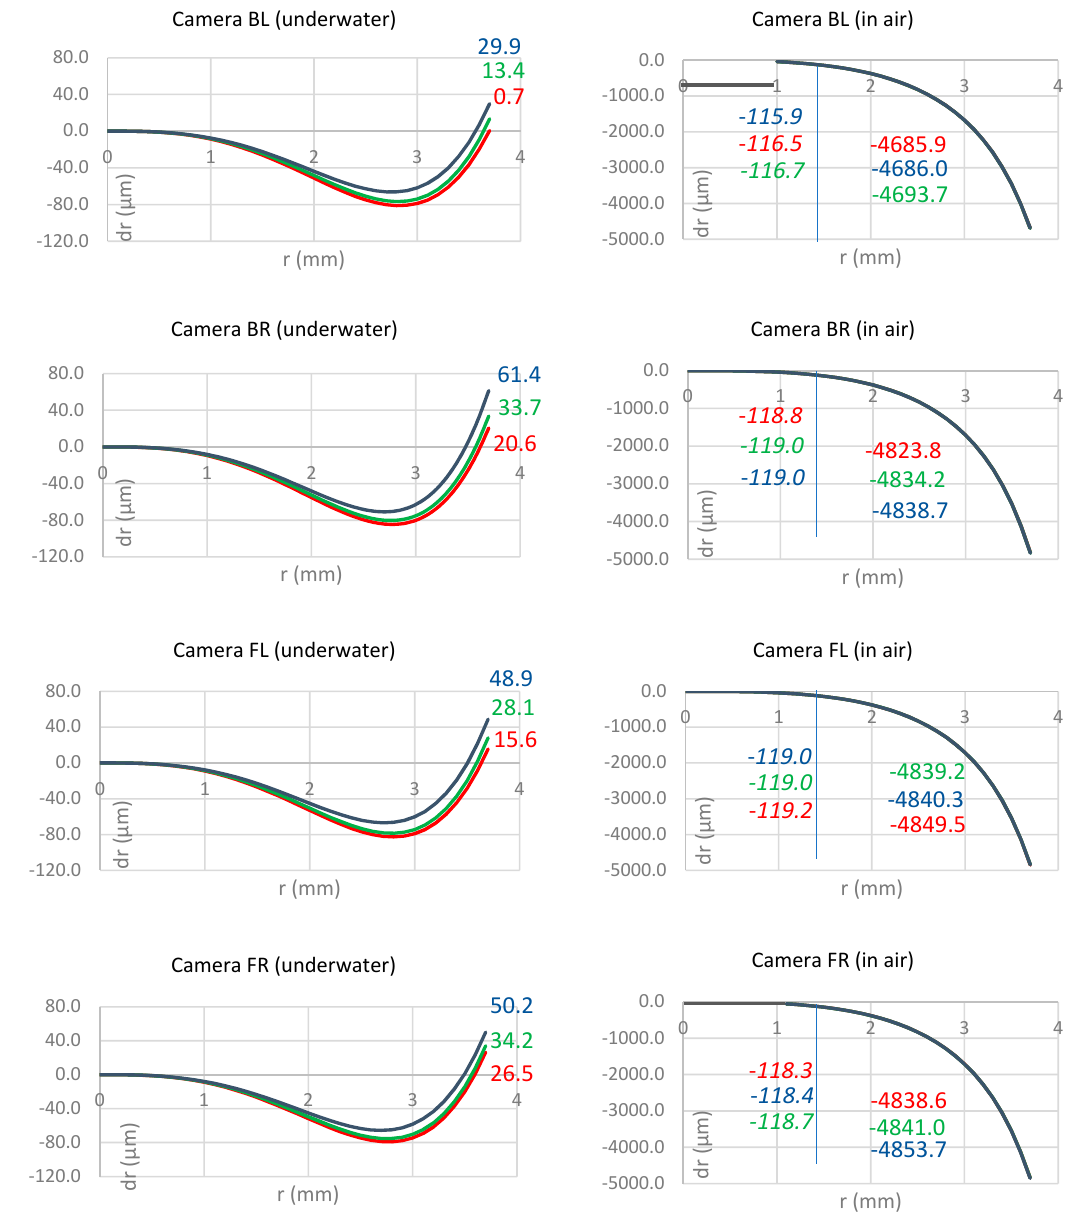
Figure 6. Comparison of the influence of the CMB calculated radial lens distortion parameters for the four different cameras (rows) in the underwater (left column) and in-air environment (right column). The colours indicate the results for the different bands (blue, green, red). Black indicates that the bands are so close to each other that the differences cannot be shown. The coloured non- italics numbers indicate the distortion in µm at the maximum radial distance. The italic numbers indicate the distortion in µm considering the scale change from underwater to in-air.